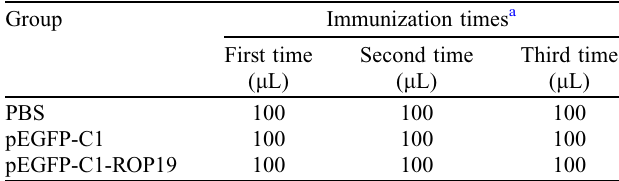
Table 1. The immunization process of BALB/c mice.